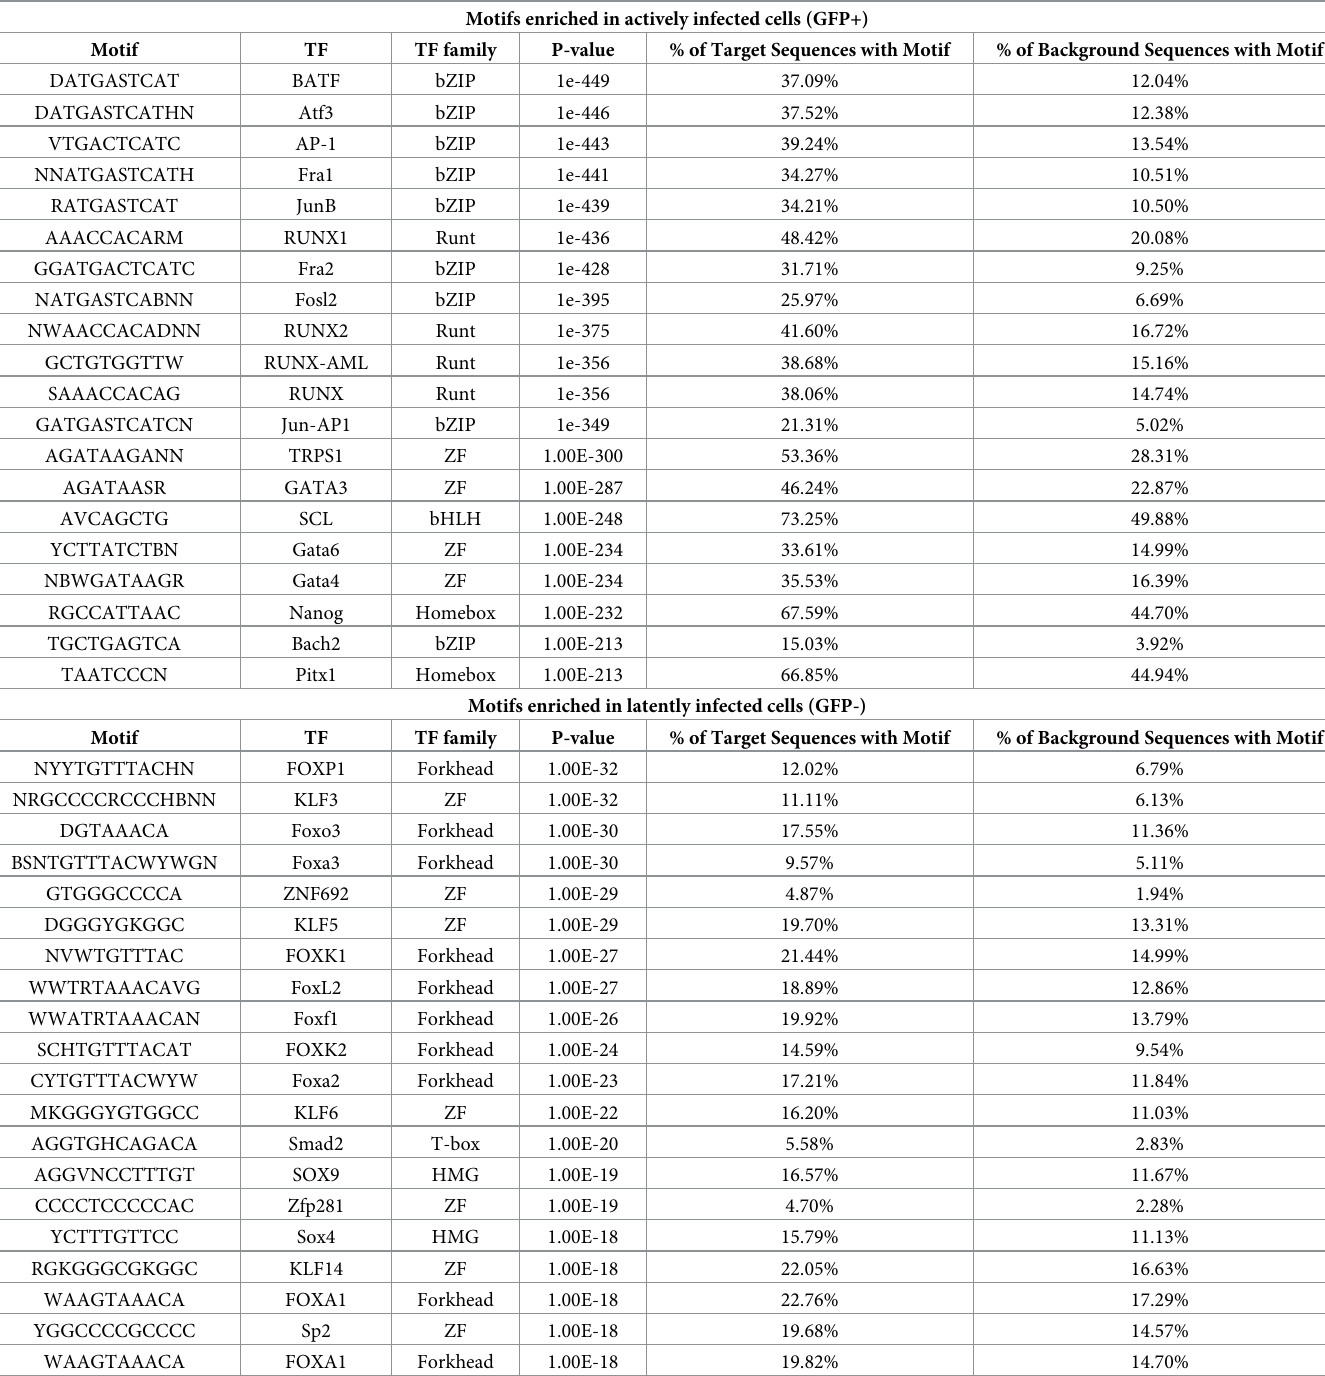
Table 1. TF motifs enriched in accessible chromatin of GFP+ vs GFP- cells. Motifs enriched in actively infected cells